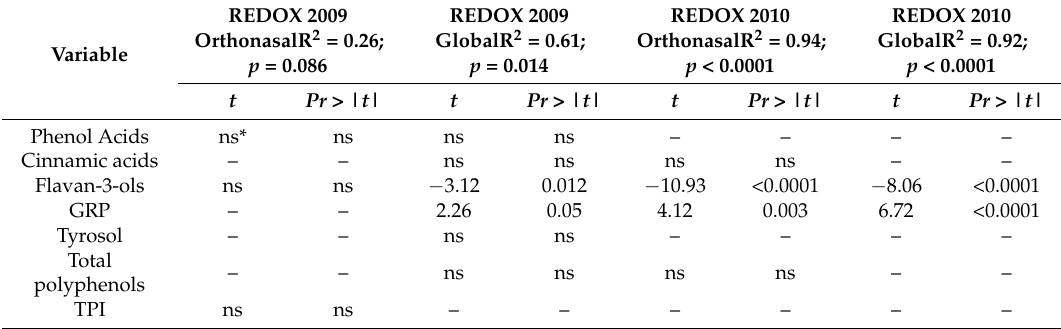
Table 8. Results of the multiple regression analysis carried out to predict REDOX odor character by phenolic concentrations. R 2 : determination coefficient of the regression; t = Student value; Pr > | t